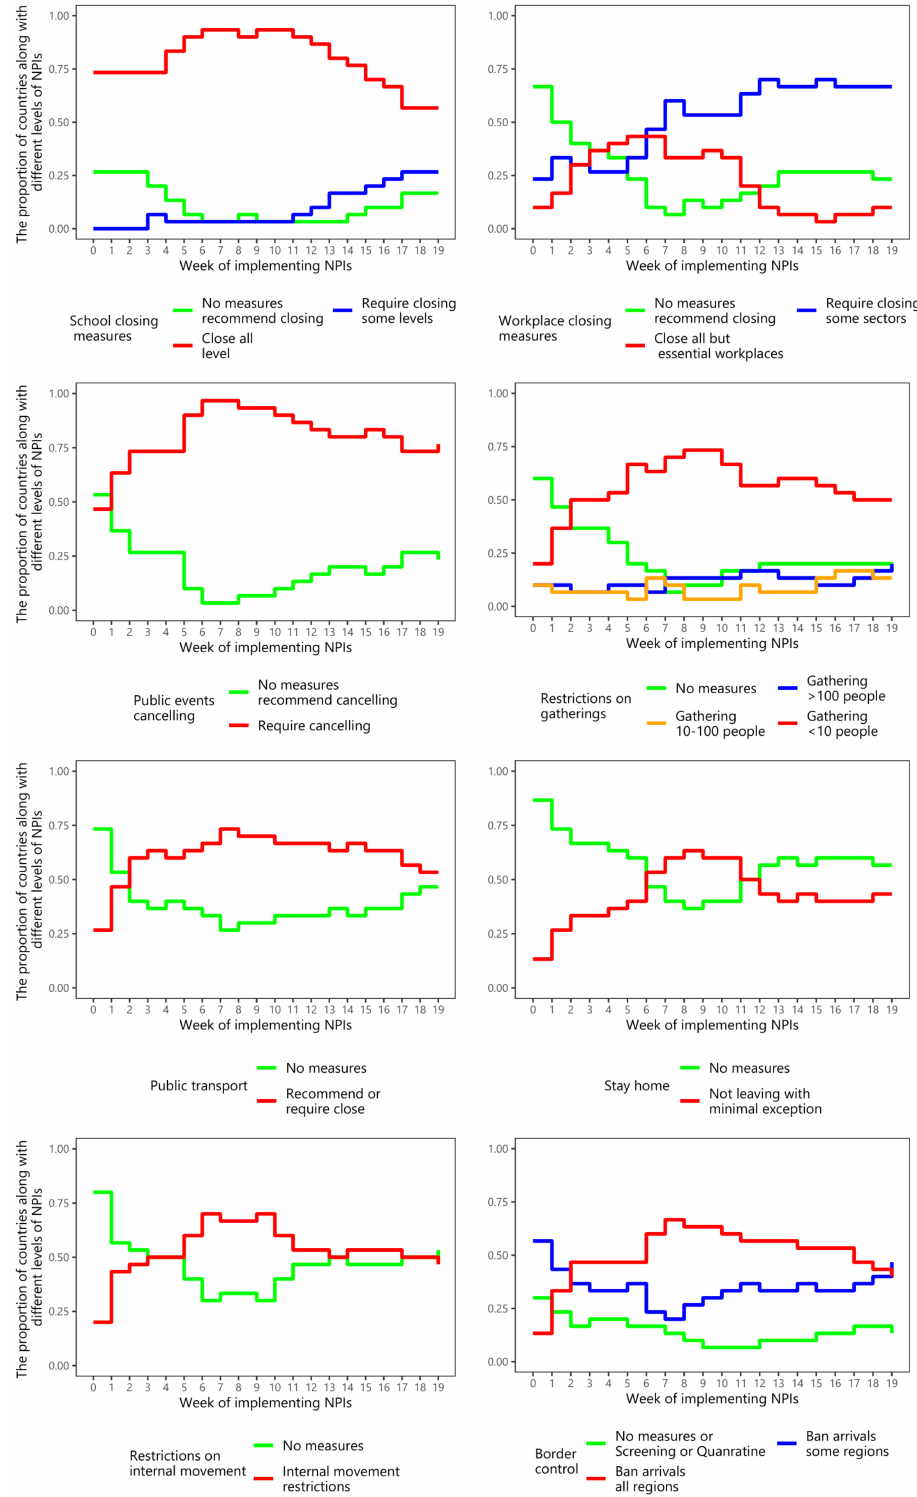
Figure 3. The proportion of countries implementing different intensities of NPIs over time among Asian countries during the pre-vaccination